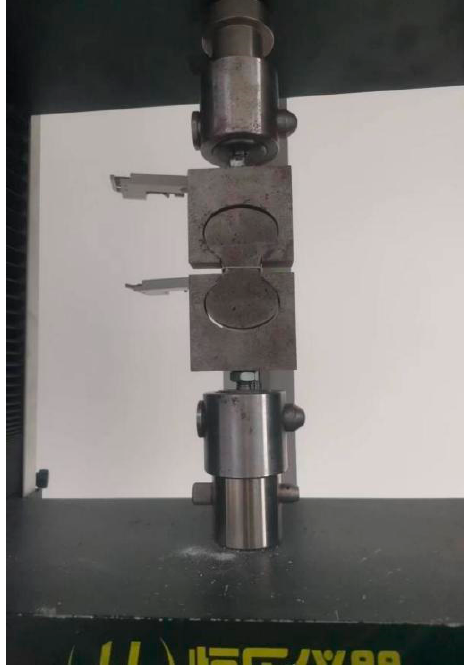
Figure 4. Loading diagram of fiber pull-out test.